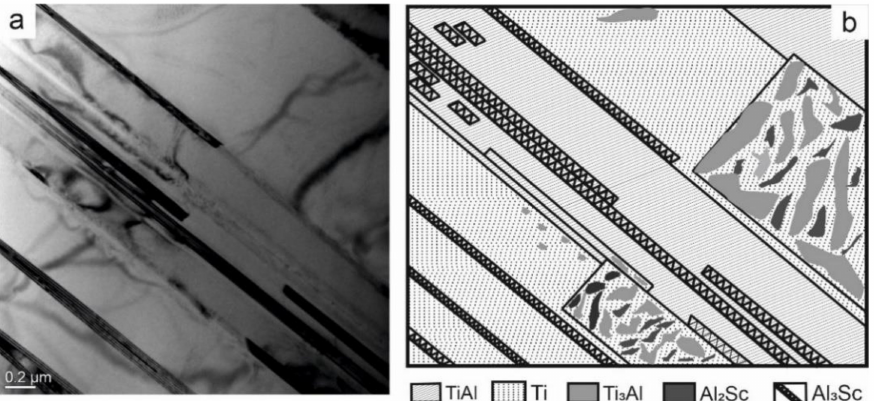
Figure 7. The bright-field image of the Ti-Al-Sc alloy ( a ) and the schema of the phases localization in the Ti-Al-Sc alloy ( b ).